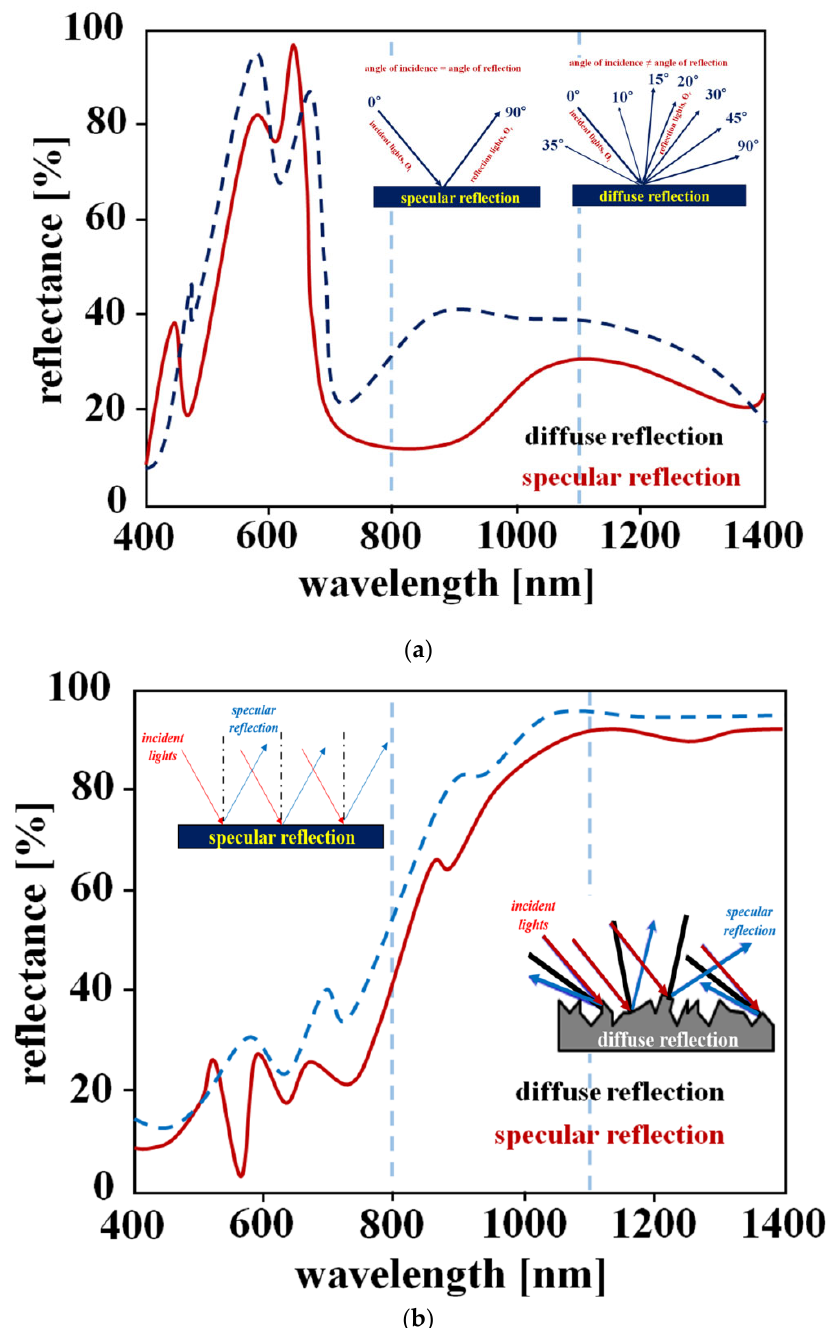
Figure 6. Light reflection coefficients ( a ) LED irradiation ( b ) fluorescence emission.